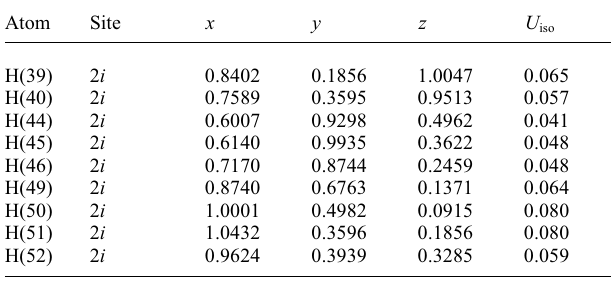
Table 3. Atomic coordinates and displacement parameters (in Å 2 )